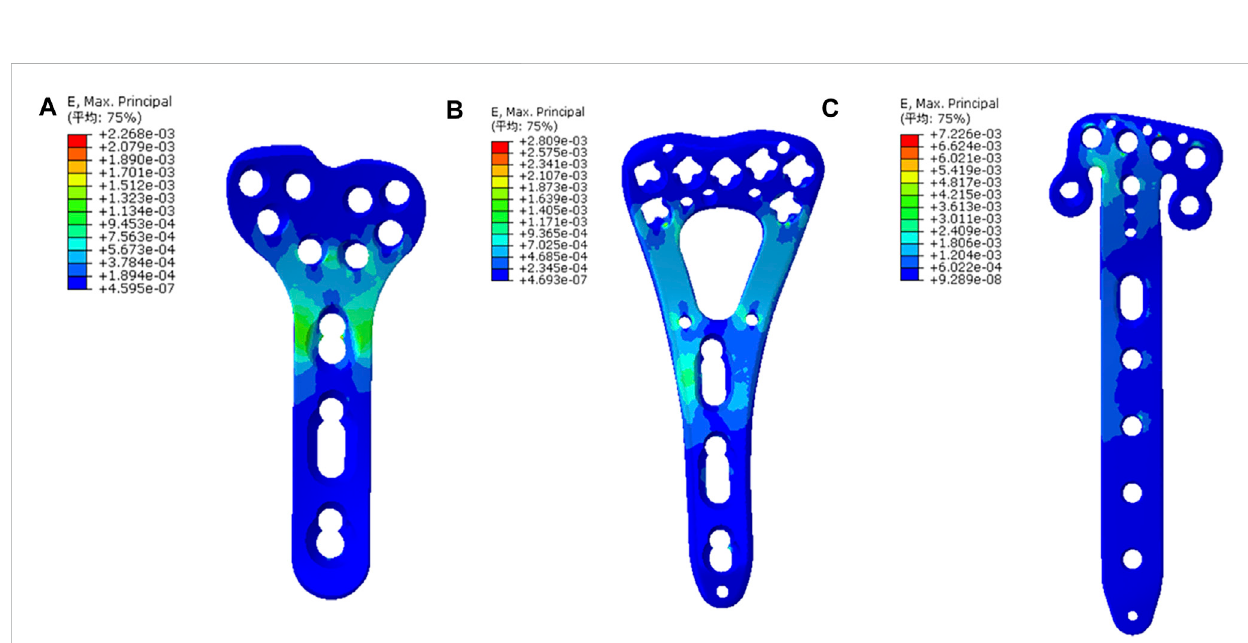
of plates, because of their lower incidences of tendon irritation and superior biomechanical stability over dorsal locking plates. However, to the best of our knowledge, a comprehensive comparison of volar locking plates with different designs has yet to be thoroughly investigated.